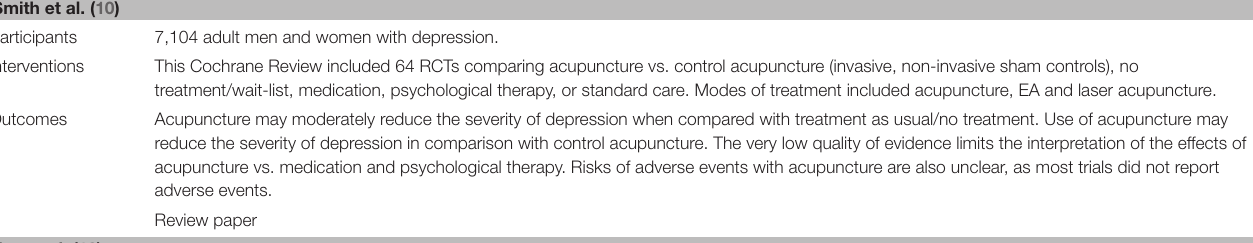
TABLE 1 | Overview of characteristics of included studies evaluating acupuncture for depression and anxiety. Smith et al.